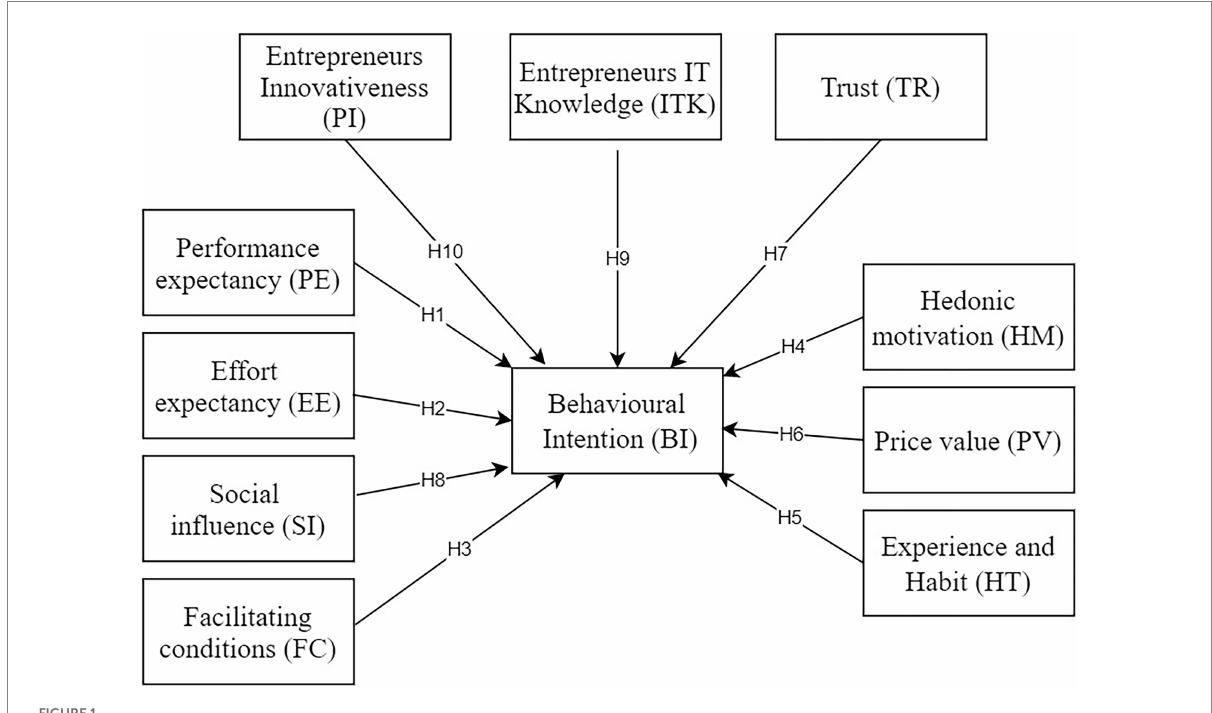
FIGURE 1 Research